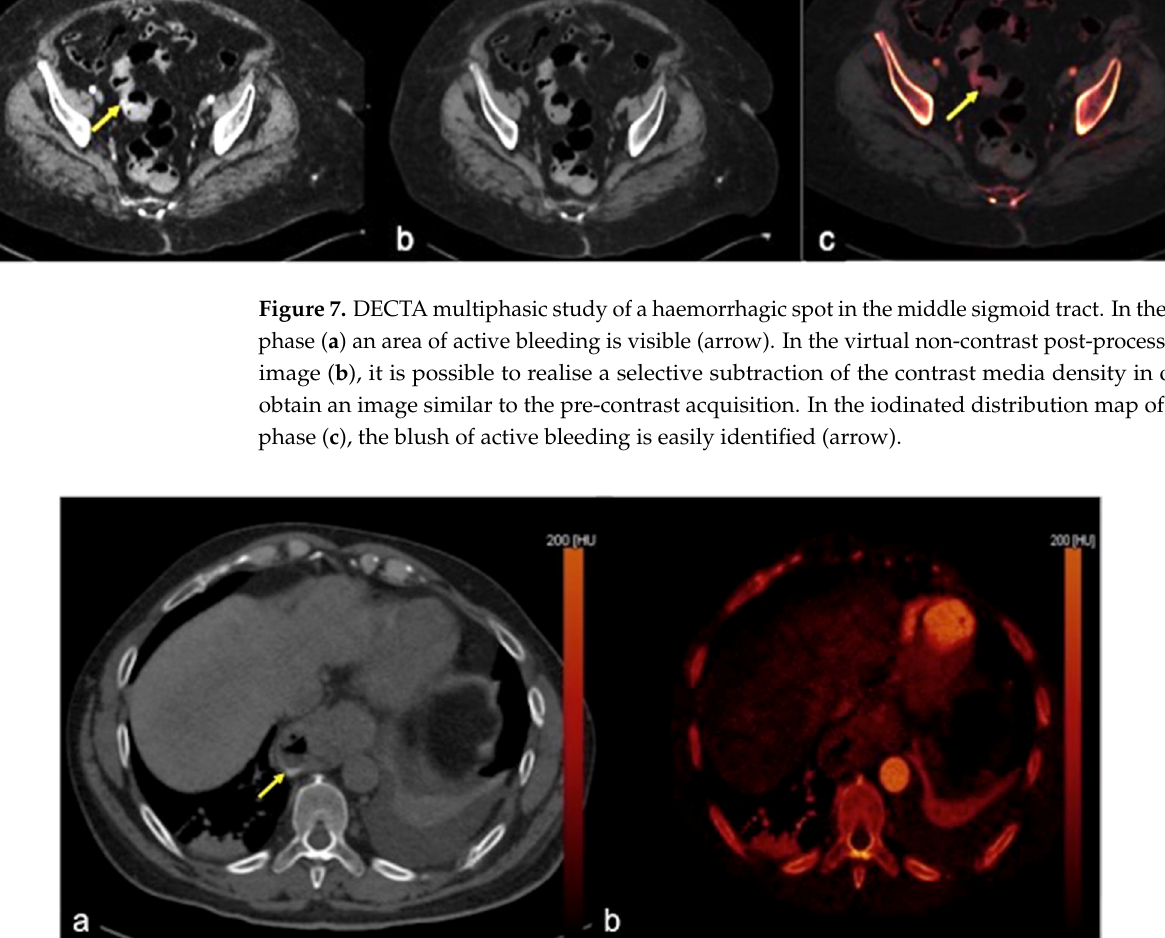
Figure 8. DECTA multiphasic study reconstruction. The virtual non-contrast axial image ( a ) shows an endoluminal linear hyperdensity in the distal oesophagus (arrow). In the iodinated map axial image ( b ) the hyperdensity is not magnified. These findings are suggestive of the presence of a foreign body, confirming the high confidence of DECTA post-processing diagnostic performance.